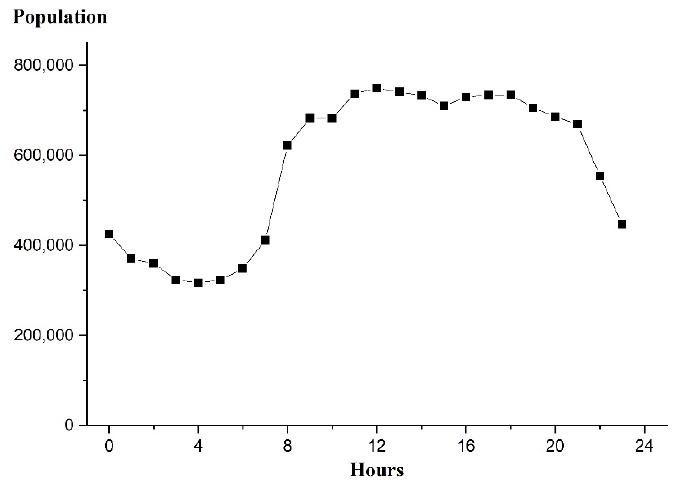
Figure 3. Population changes in the study area over 24 h. Table 2. The number of refugees at each moment and the age structure of the demand